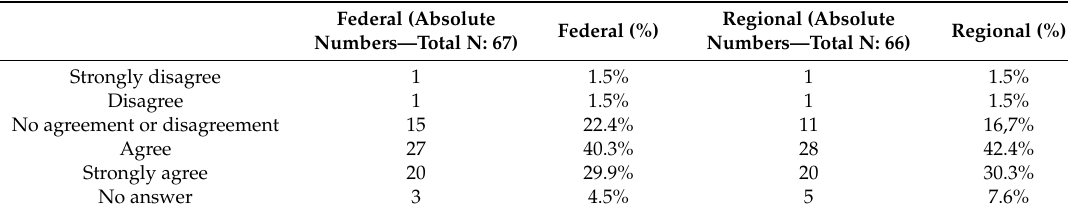
Table 6. Willingness to engage in more active future collaboration across different governmental levels. Federal (Absolute Numbers—Total N: